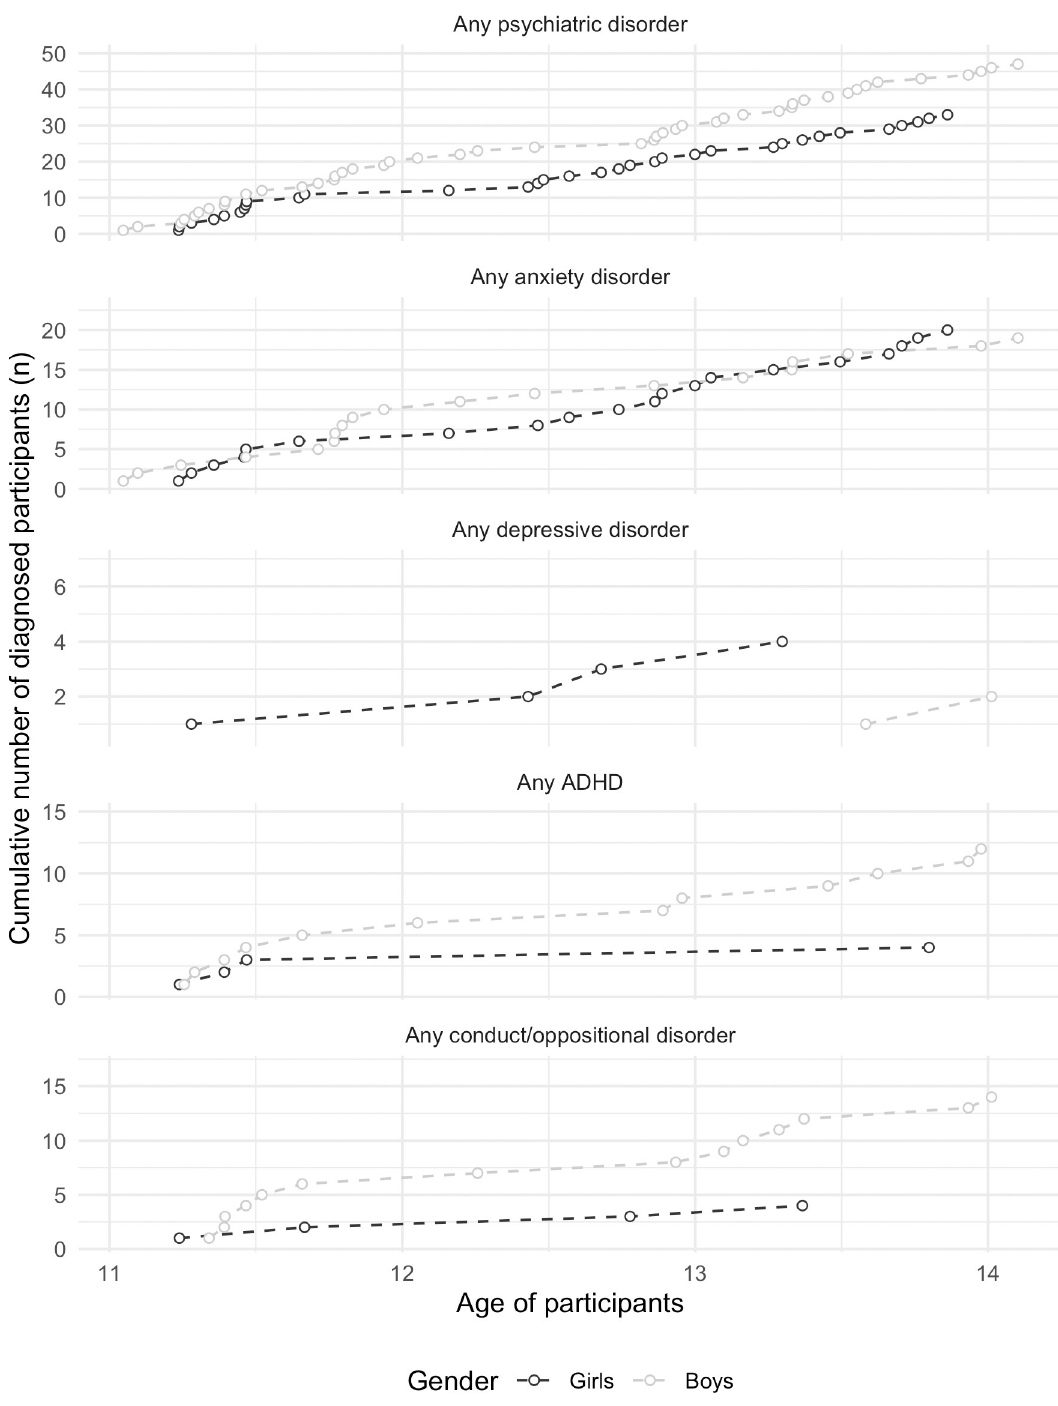
Fig 3. Cumulative number of diagnosed participants by age. Observed frequencies. The points represent the cumulative number of participants with a diagnosis at each age. The scales on the y-axis are free as the cumulative frequencies vary by psychiatric disorder.